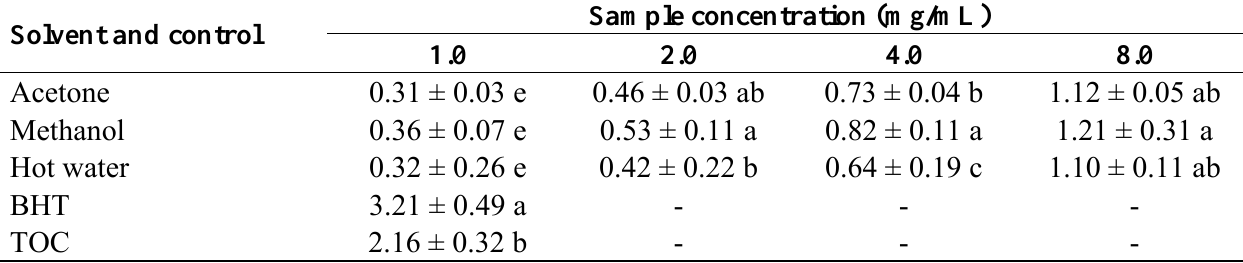
Table 2. Reducing power of different concentrations of various extracts from the fruiting bodies of Lentinus lepideus .